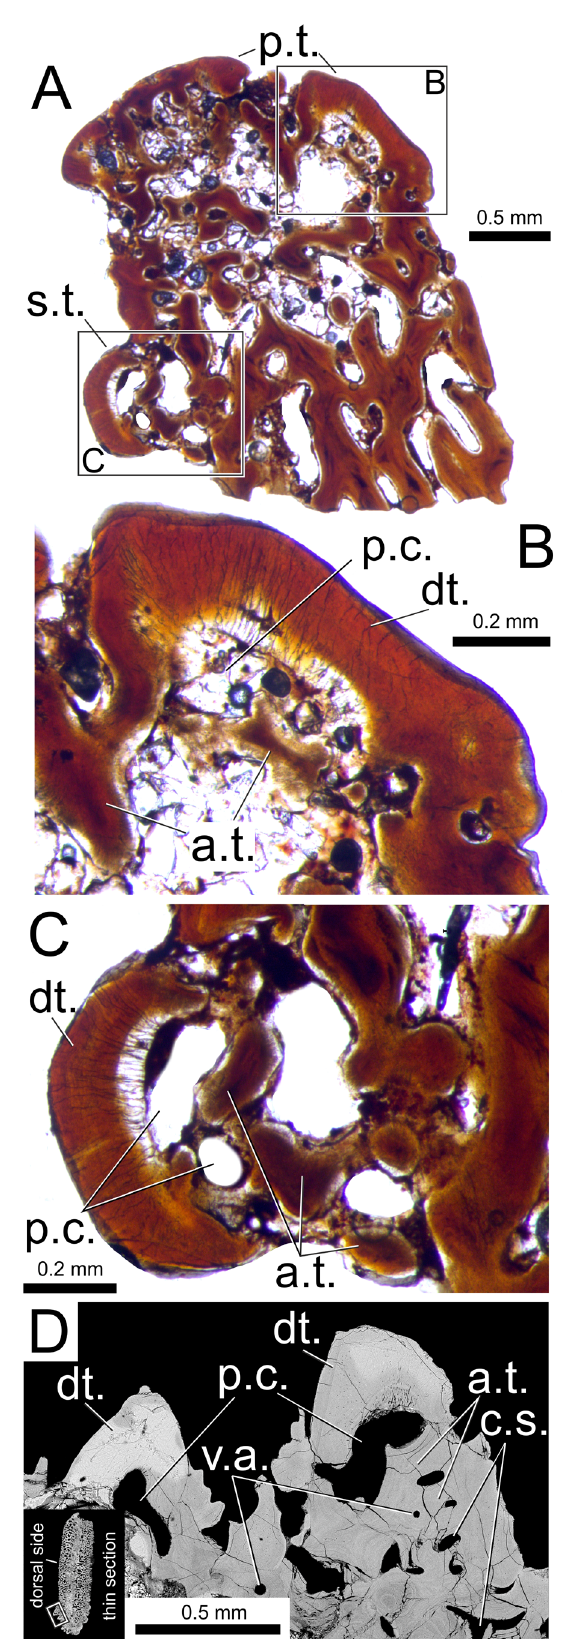
branchial plate (D) of Psammosteus ramosus sp. nov.